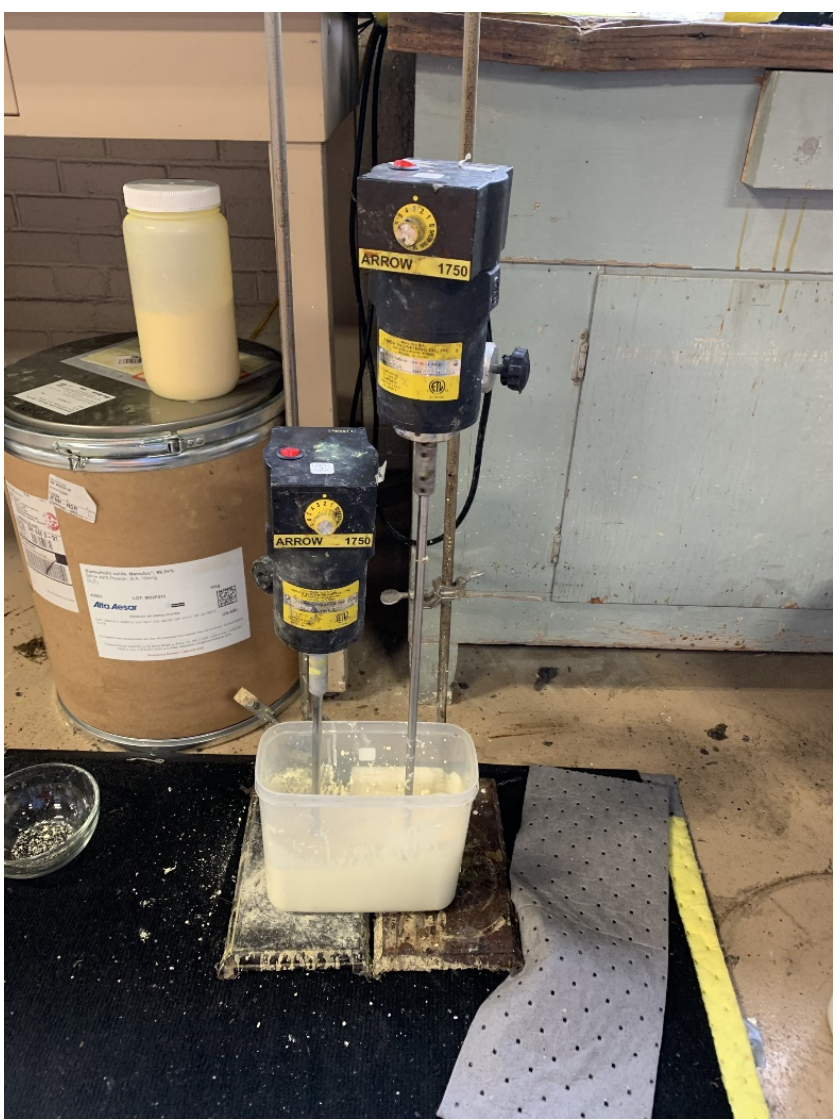
Figure 1. Compounding of micro-Bi 2 O 3 in the GNRL.